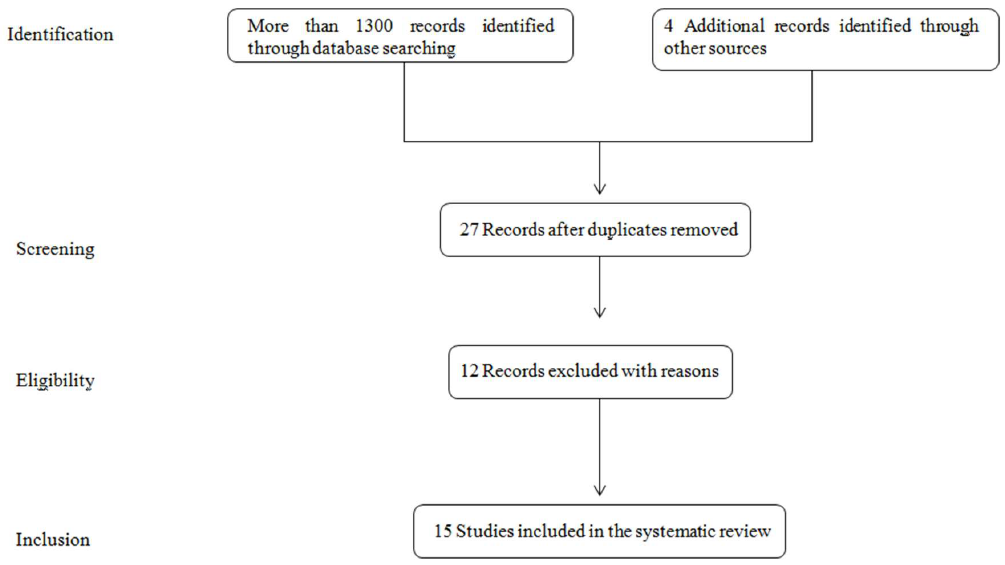
Figure 1. Study selection